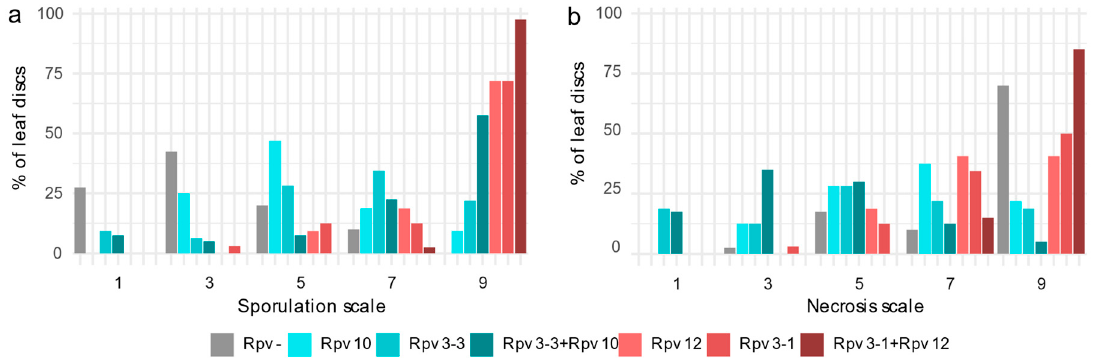
Figure 2. Leaf disc classification according to the dual-scale system. Sporulation and necrosis rating are reported in panels “a” and “b”, respectively. Shades of blue identify the progenies of Solaris (RPxS). Shades of red the progenies of Kozma 20-3 (RPxK). Gray represents the Rpv- genotypes.